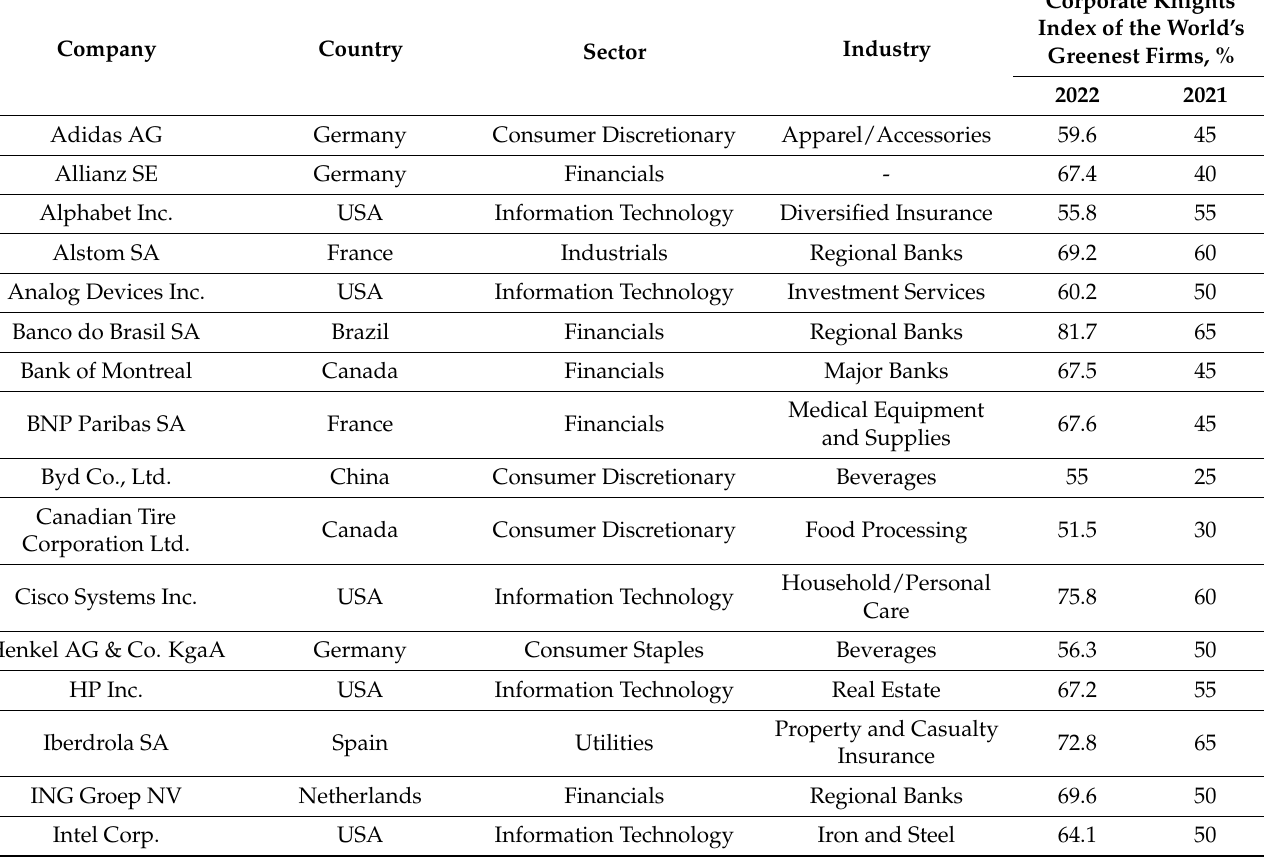
Table A1. Country and industry characteristics of the sample, as well as Corporate Knights’ Index of the world’s greenest firms in 2020–2021,